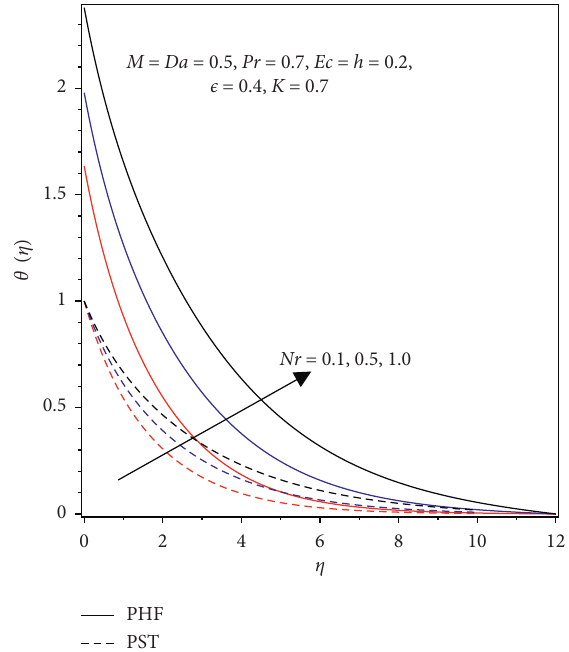
Figure 8: Influence of radiation parameter Nr on the profiles of temperature.